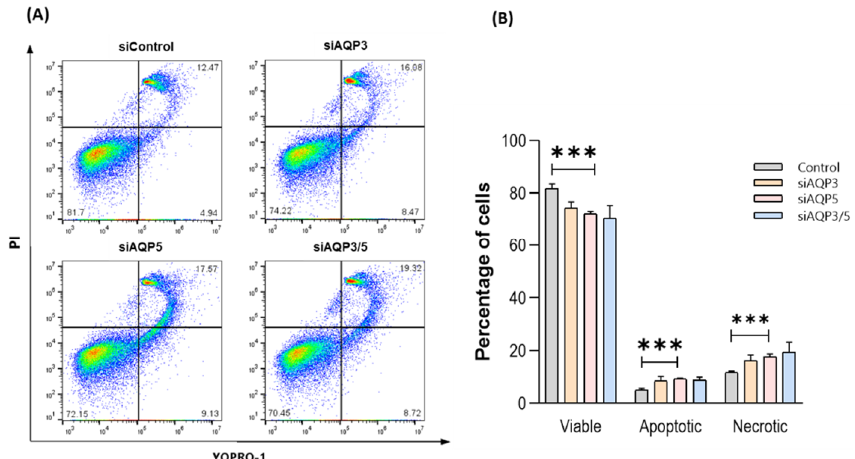
Figure 7. AQP5 is crucial for cell viability. ( A ) Cell viability analysis of control, siAQP3, siAQP5, and siAQP3/5 BxPC-3 cells stained with YO-PRO-1 and PI. Cells in the lower right quadrant are in early apoptosis, and those in the upper right quadrant are in mid and late apoptosis. ( B ) Percentage of viable, apoptotic, and necrotic cells. Results are expressed as mean ± SEM of three independent experiments. *** p < 0.001, silenced vs. control cells.